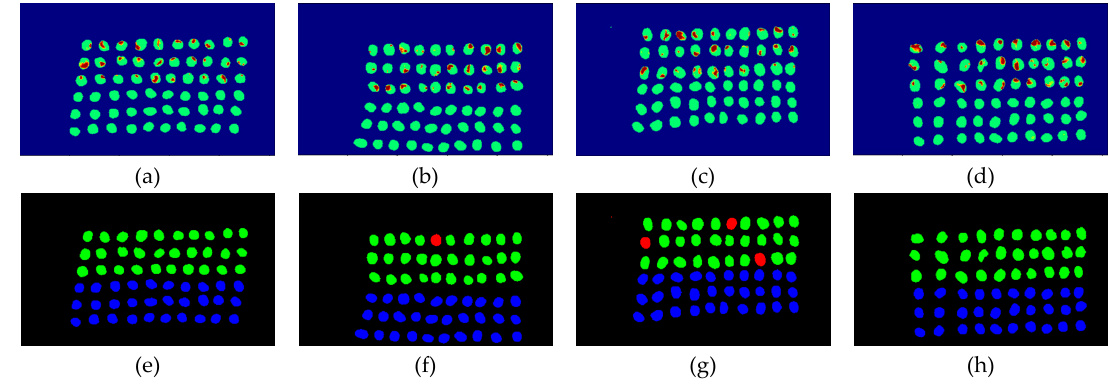
Figure 47. Results of green coffee bean CNN+SB_CTBS 20 bands. (a-d) CNN classification results, (e- h) final visual images.